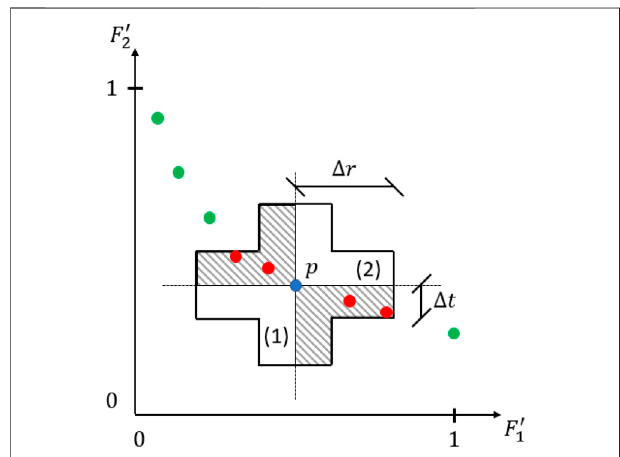
FIGURE 3| Graphical representation ofthe PIT-region of asolution p for anoptimisationproblemwithnormalisedobjectives F ′ 1 and F ′ 2 [adaptedfrom Mattson et al.,